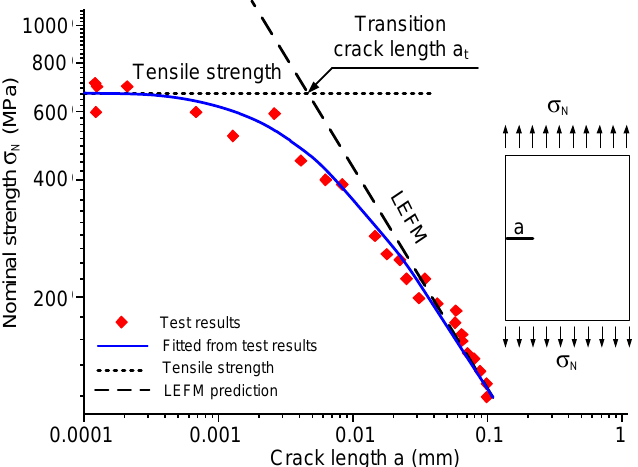
Figure 2. Nominal strengths versus crack length in SiC (modified from